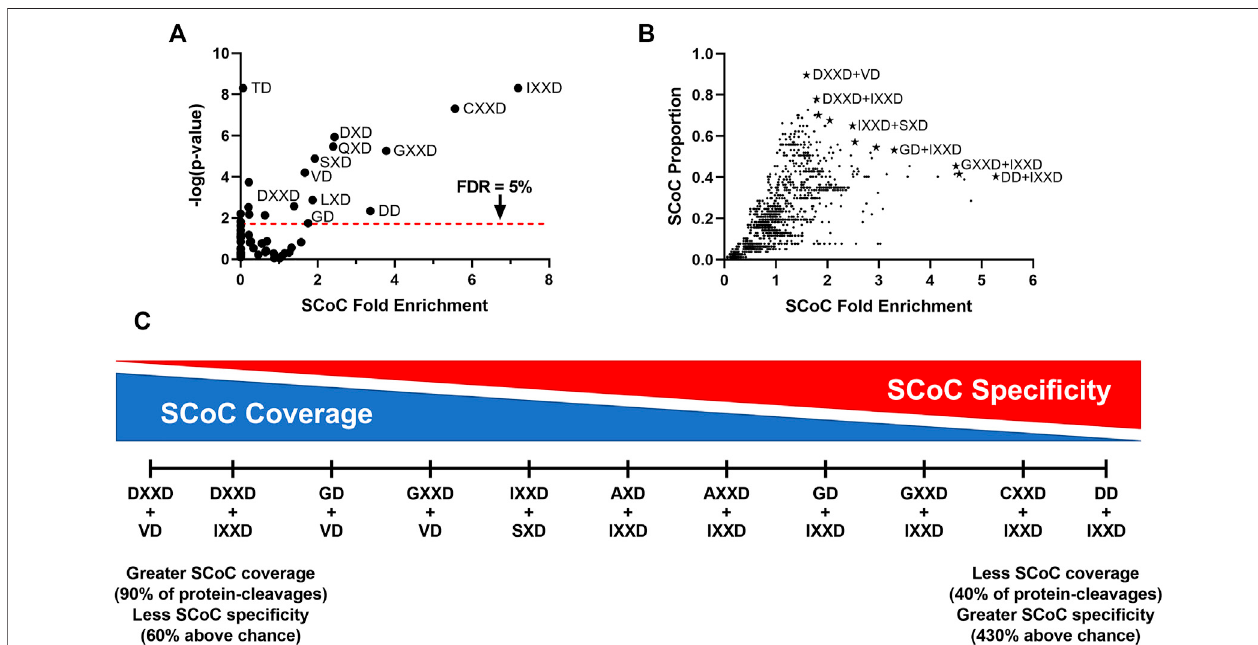
FIGURE 4 | SCoC-speci fi c motifs in the Degrabase represent likely candidates for human non-apoptotic consensus sequences. (A) To identify motifs associated with SCoC protein-cleavages, Monte Carlo analyses were used to simulate cleavage events at each P4-P2 motif in SCoC caspase substrates from the Degrabase, a database of cleavage events in human cell lines. The observed protein-cleavage count for each motif was compared to the random distribution of expected protein- cleavages to calculate SCoC fold enrichment and p -values. We identi fi ed 11 motifs that were signi fi cantly associated with SCoC protein-cleavages, including 2 motifspresentin the chick non-apoptotic consensus sequence (GD and IXXD). p -valuesfor IXXD and TD are maximum estimates, as none of the 10 million Monte Carlo simulations yielded the observed protein-cleavages for these motifs. (B) As with single motifs, Monte Carlo analyses were used to estimate SCoC fold enrichment and p -values for observed protein-cleavages of non-redundant motif combinations. The proportion of observed SCoC protein-cleavages for each motif was plotted against the SCoC fold enrichment to identify motif combinations likely to be preferred in human non-apoptotic caspase-dependent processes (starred datapoints). These 11 candidates were selected in a stepwise fashion, beginning with the motif combination that had the highest SCoC fold enrichment and including additional motifs with lower SCoC fold enrichment only if they also had a higher SCoC protein-cleavage proportion. Labels of select candidates are shown. All 11 candidates had p -values belowthe5%family-wise error ratecutoff, 2.8×10 – 5 . Motif combinationsofIXXD, CXXD, orGXXD and any motifwith0or1observedprotein-cleavages arenot shown, asthesecombinationstendedtohavearti fi ciallyin fl atedfoldenrichmentvaluesdespitebeingunlikelycandidatesforanSCoC-directedconsensussequence. (C) The11 motifcombinationswithmaximumSCoCprotein-cleavageproportionsfortheirgivenSCoCfoldenrichmentrepresentaspectrumwithatradeoffbetweenhighcoverage of SCoC protein-cleavages and high speci fi city for SCoC protein-cleavages. FDR, False Discovery Rate, derived by Benjamini, Krieger, and Yekutieli correction.